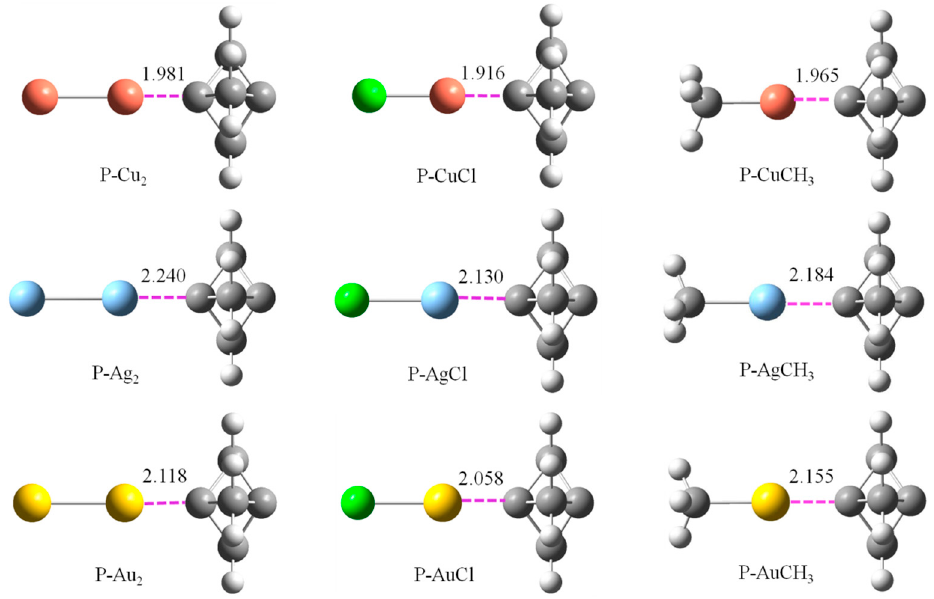
Figure 1. Optimized structures of binary systems with the M-C distance (Å) at the wB97X-D/aug-cc-pVTZ(PP)